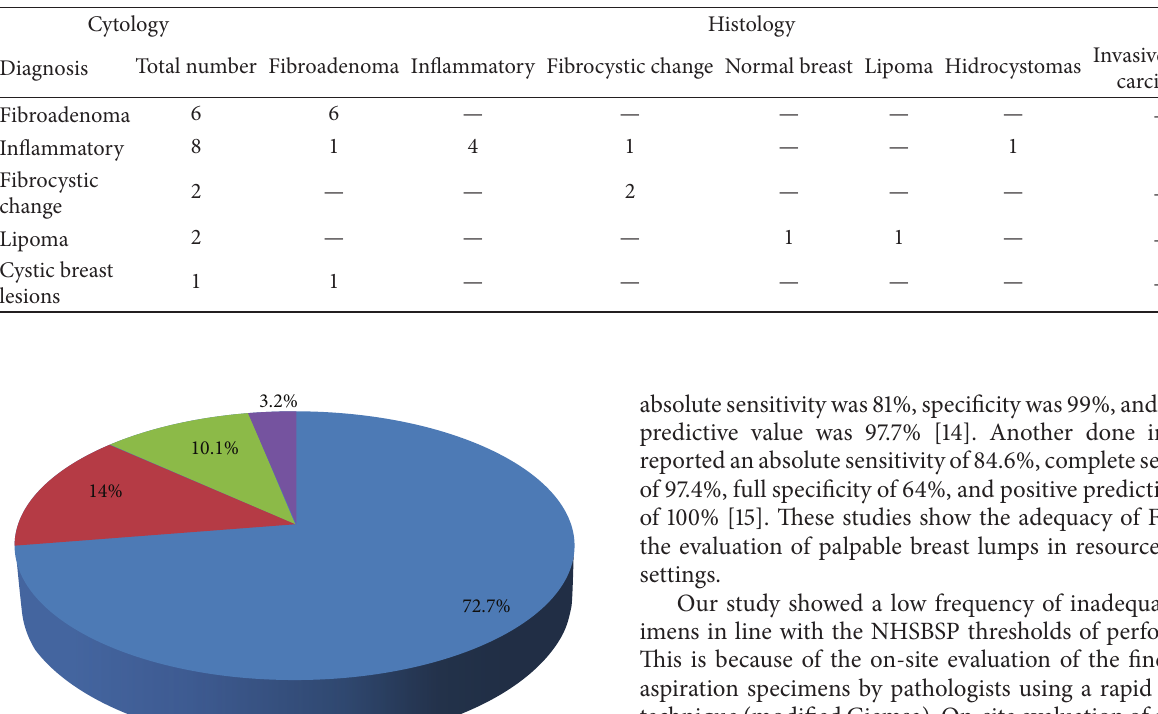
Table 3: Correlation of specific cytologic and histologic diagnoses.